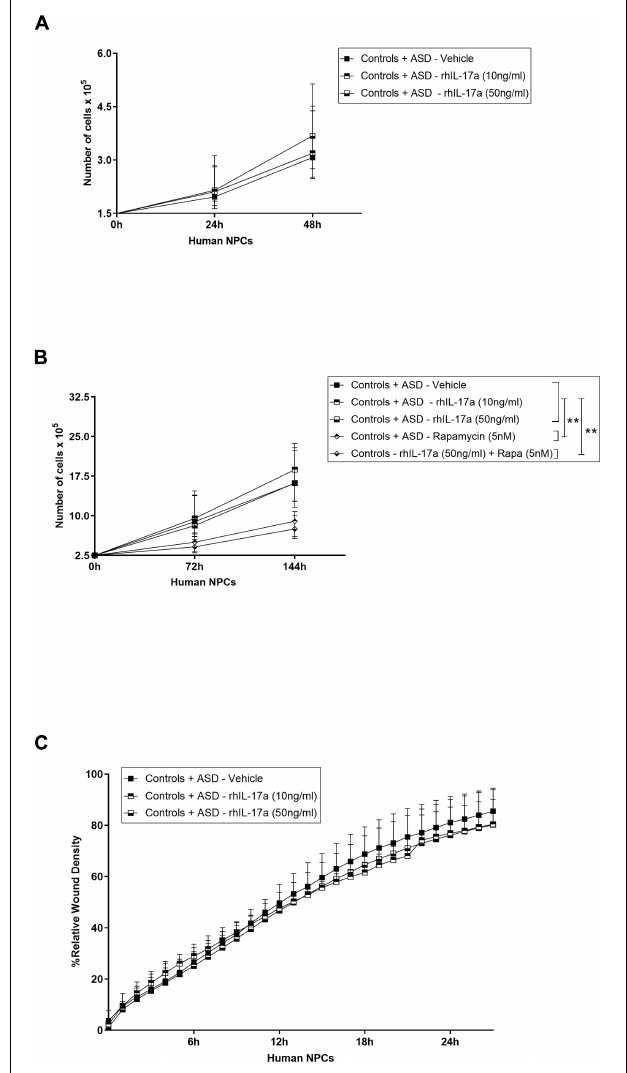
FIGURE 2 | Exogenous IL-17a does not affect the proliferation and migration of human NPCs. (A) Line graph showing cell proliferation curves of iPSC-derived NPCs of control ( n = 5) and ASD ( n = 6) subjects cultured in the presence of either vehicle or rhIL-17a (10 and 50 ng/ml) for 24 and 48 h. (B) Line graph showing cell proliferation curves of iPSC-derived NPCs of control ( n = 5) and ASD ( n = 6) subjects cultured in the presence of either vehicle, or rhIL-17a (10 and 50 ng/ml), or rapamycin (5 nM, used as control), or rhIL-17a (50 ng/ml) plus rapamycin (5 nM) for 72 and 144 h. While rapamycin-treated human NPCs showed significantly decreased proliferation, ** p ≤ 0.01, no significant differences were observed in the proliferation rates between rhIL-17a-treated and untreated human NPCs. (C) Line graph of mean% relative wound density over time in iPSC-derived NPCs of control ( n = 5) and ASD ( n = 3) subjects cultured in the presence of either vehicle or rhIL-17a (10 and 50 ng/ml) for 24 h. No significant differences were observed in the migration rates between rhIL-17a-treated and untreated human